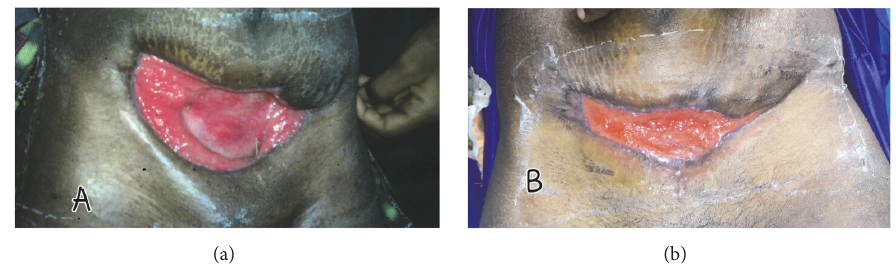
Figure 4: (a) and (b) Depicting wound healing process at weeks 15 and 22, respectively.